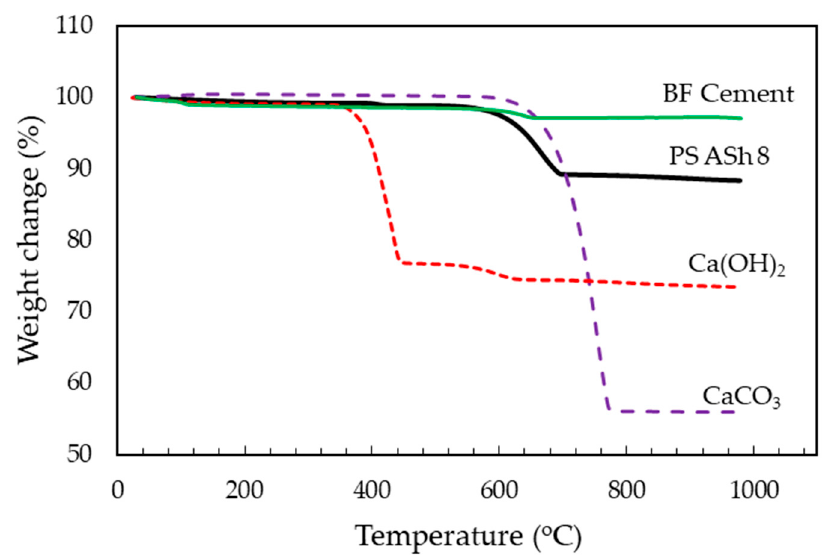
Figure 1. Thermogravimetric (TG) curves show the thermal decomposition of Ca(OH) 2 , CaCO 3 , PS ash 8, and BF cement in a N 2 atmosphere.